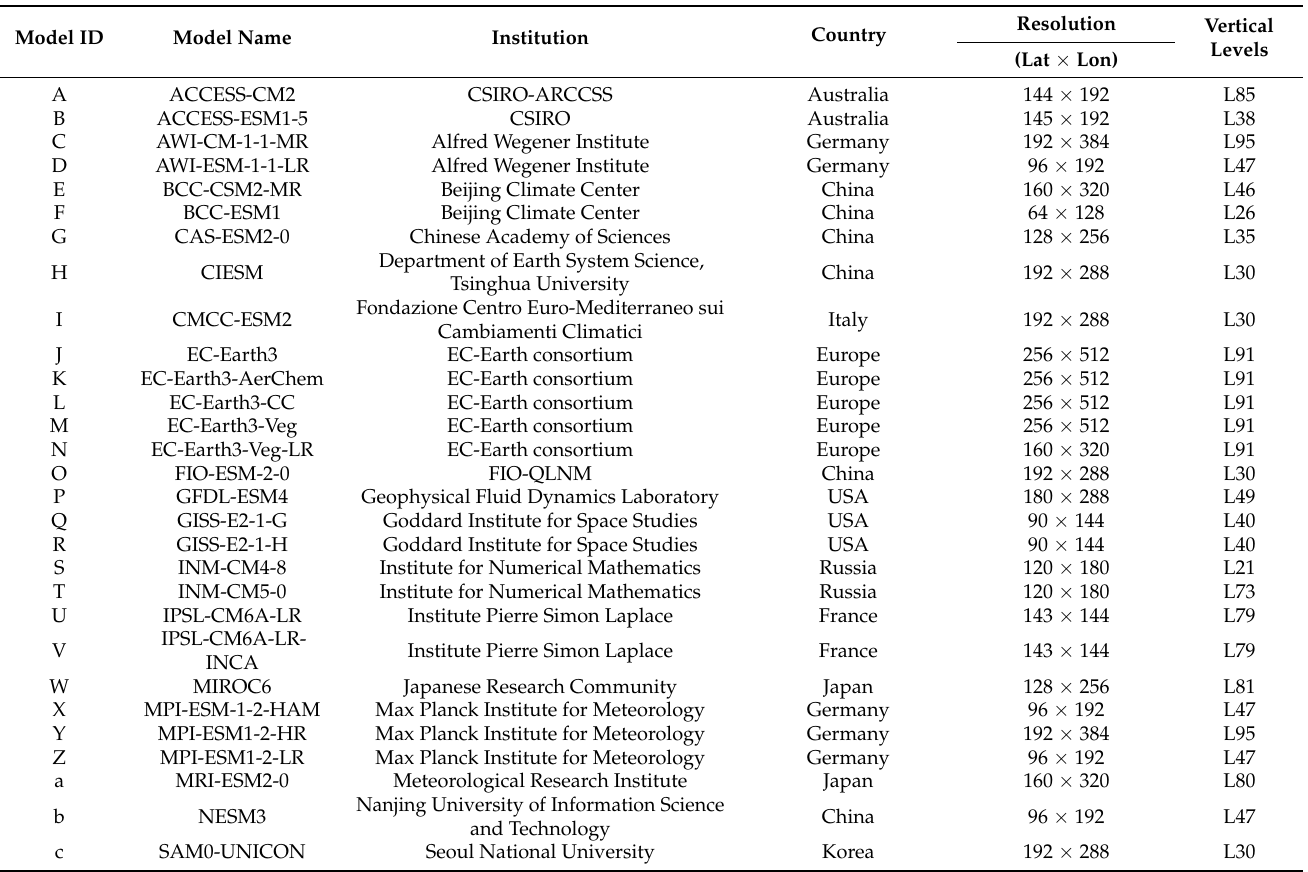
Table 2. Basic information regarding the 29 CMIP6